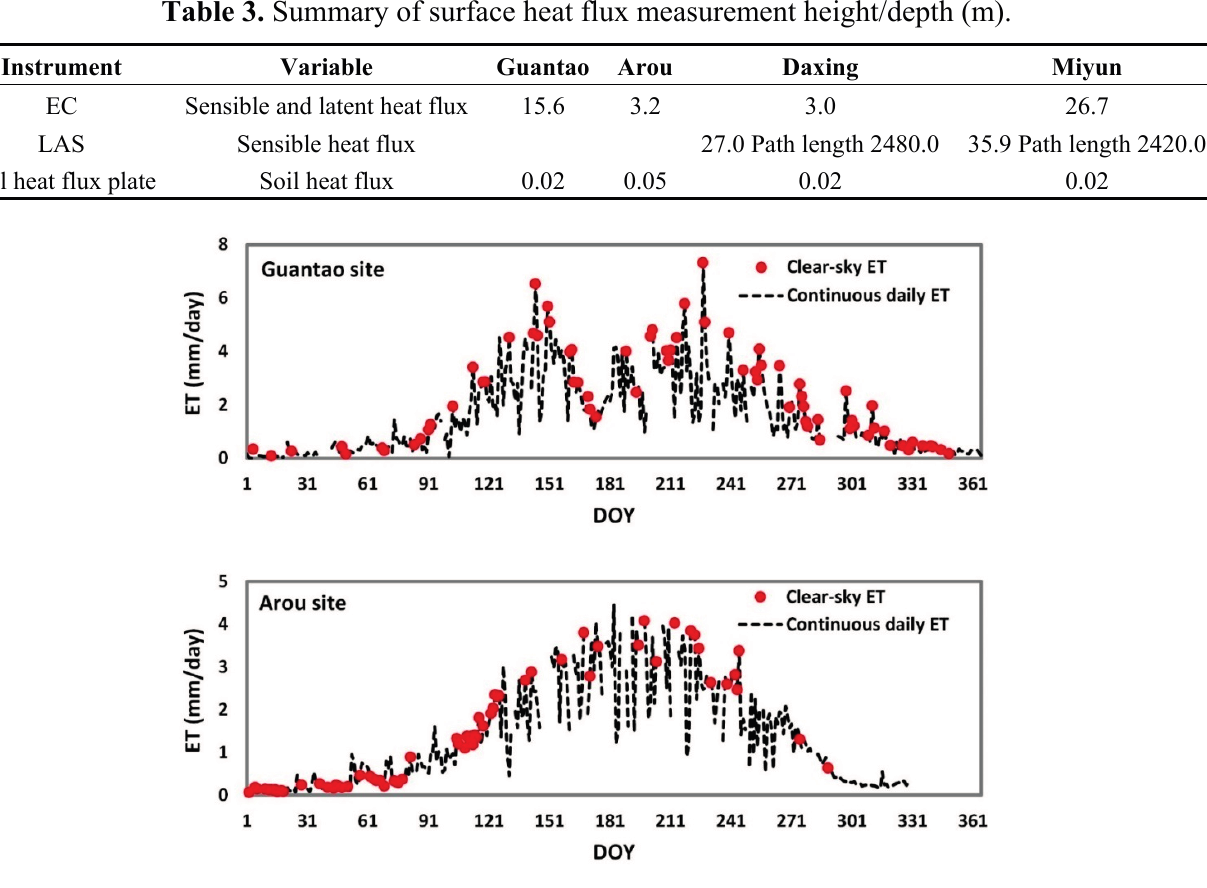
Figure 1. The temporal distribution of clear-sky daily evapotranspiration (ET) over the whole